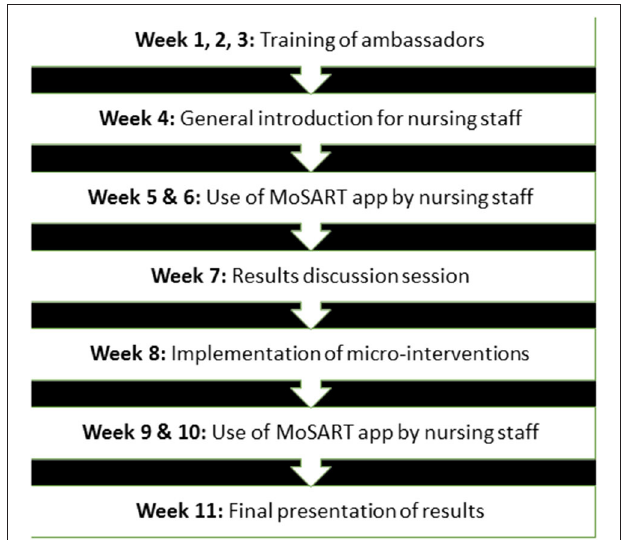
FIGURE 3 | Chronological overview of the MoSART + intervention by week.